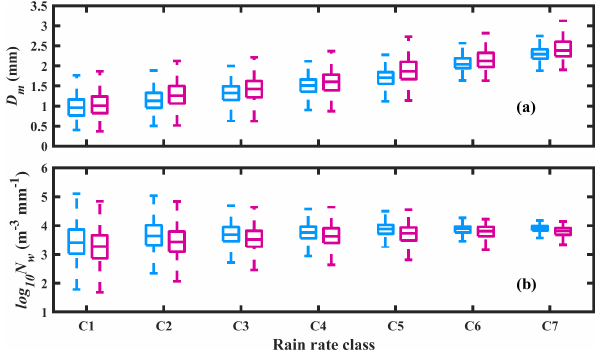
Figure 7. Box plot of (a) D m (mm) and (b) log 10 N w (mm − 1 m − 3 ) in seven rainfall rate classes for typhoon (TY; sky blue) and non- typhoon (NTY; dark magenta) rainfall. The center line of the box indicates the median, and the bottom and top lines of the box in- dicate the 25th and 75th percentiles, respectively. The bottom and top of the dashed vertical lines indicate the 5th and 95th percentiles,